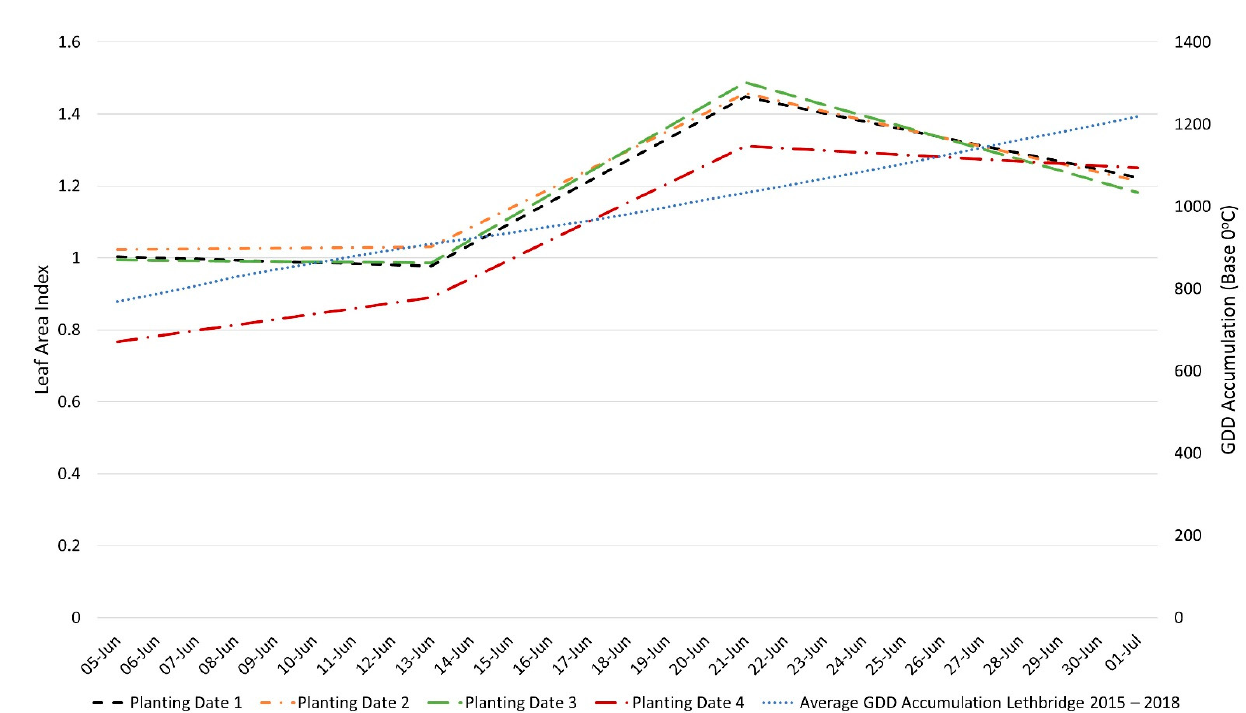
Figure 4. Average leaf area index (LAI) values from 5 June to 1 July at Lethbridge, Alberta sites 2015–2018 for each planting date, overlaid with 2015–2018 average GDD B 0 accumulation during the same time period. Planting dates 1–3 had significantly greater LAI than planting date 4 on June 5 ( p < 0.05). No significant differences in LAI between planting times was present 13 June to 1 July.